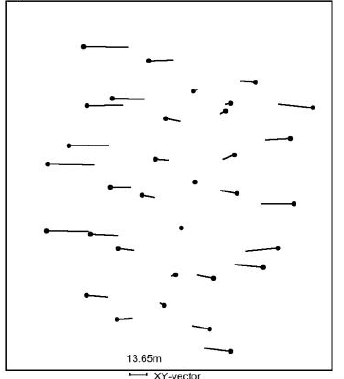
Figure 22. Discrepancies at GCPs – forward camera, RPC orientation with bias correction by shift